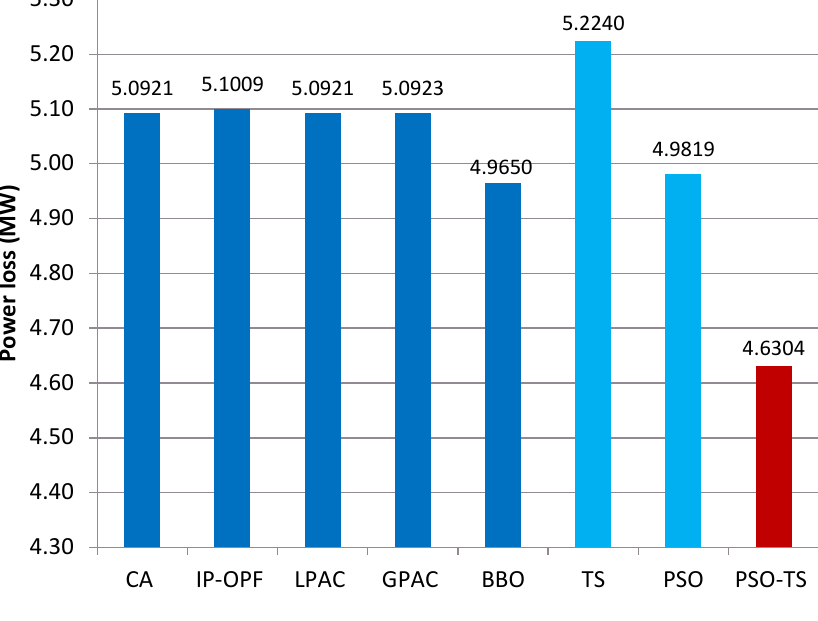
Figure 5. Comparative graph of the power losses (Case 1).